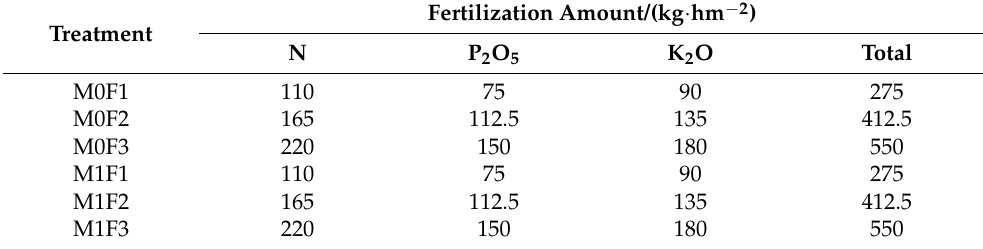
Table 1. Experiment